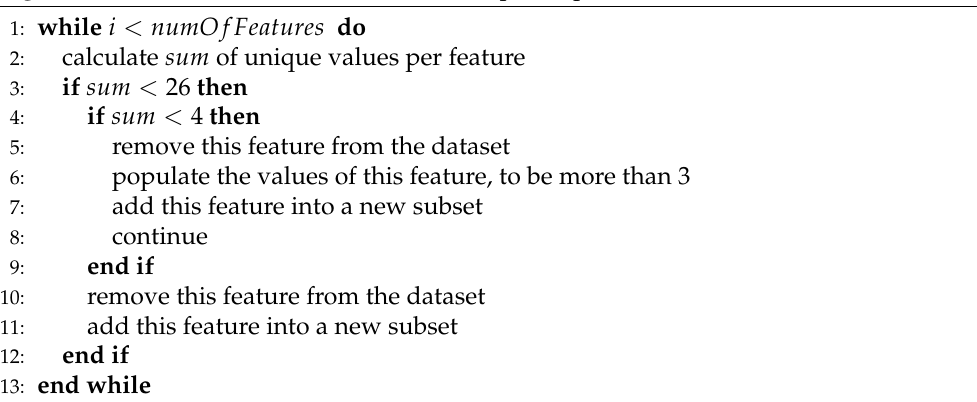
Algorithm 1 Pseudocode for SMOTE-NC samples